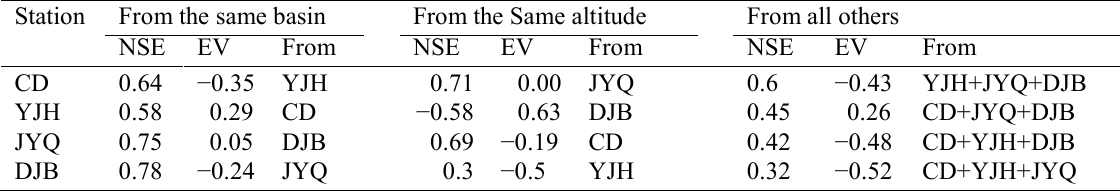
Table 5 The NSE and EV at the four hydrological stations by borrowing the parameters from the station within the same basin, from the station located in the same altitude and from the average of all the gauged station, at daily scale. Station